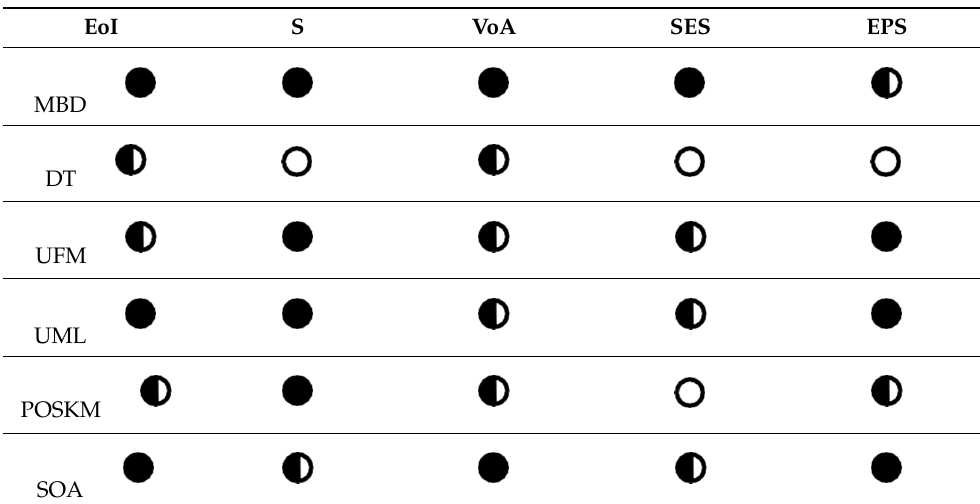
Black circle = fully integrated; White circle = not integrated; Black & White = partially